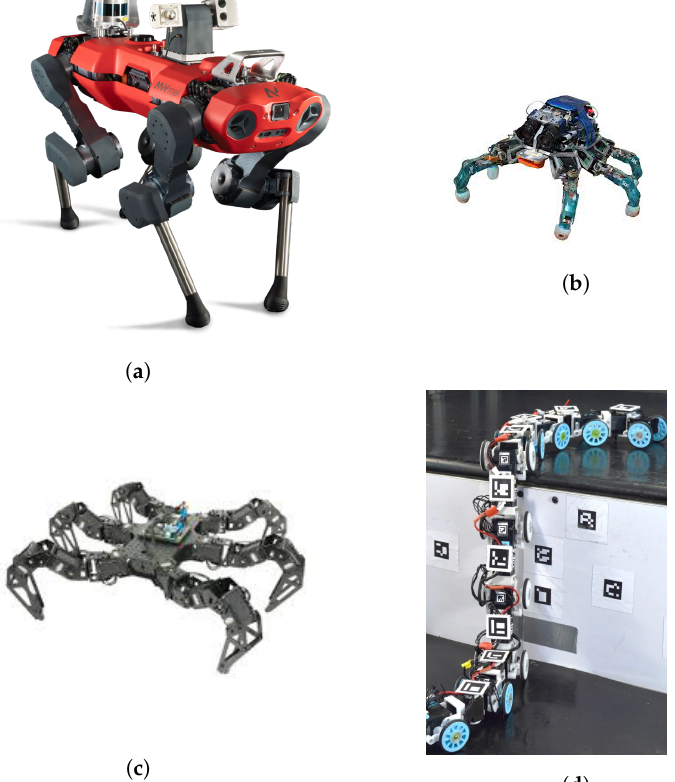
Figure 2. Examples of bio-inspired robots: ( a ) Anymal C from ANYbotics. Reproduced,